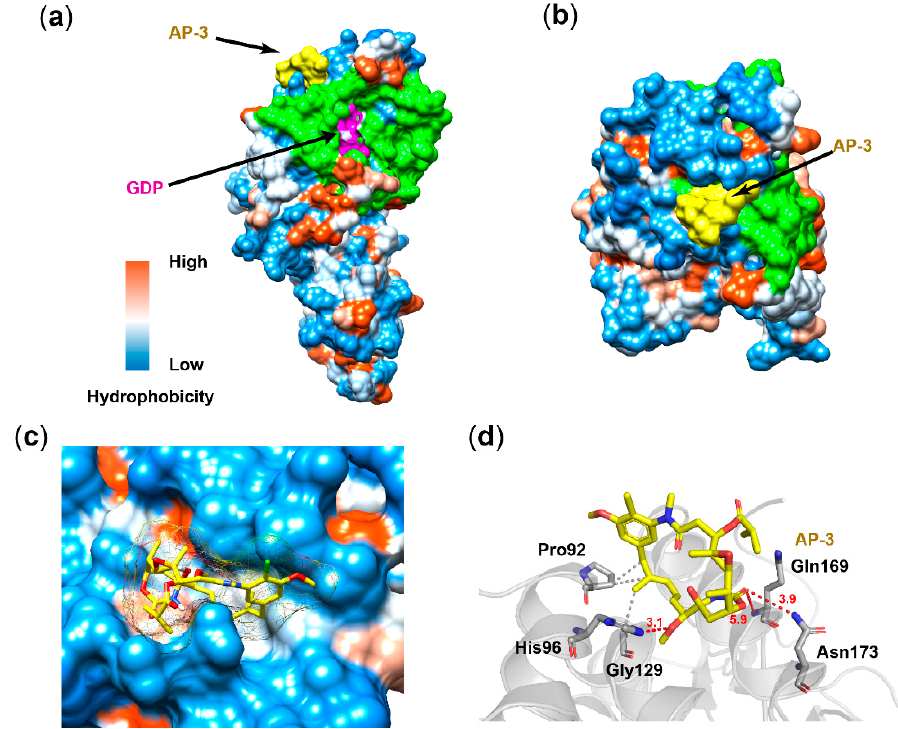
Figure 4. Interaction of FtsZ and AP-3 revealed by docking analysis. ( a ) The binding site of AP-3 on FtsZ is apart from the GDP binding site, from side view. The surface of FtsZ is displayed by hydrophobicity. Orange and blue indicate high and low hydrophobicity, respectively. The junction interphase between two FtsZ monomers is colored in green. ( b ) The binding site of AP-3 on FtsZ, from top view. ( c ) Close-up view of the AP-3 binding groove on FtsZ. The colors on the groove indicate that this part is more hydrophobic than the surrounding area. ( d ) The key amino acid residues interacting with AP-3. The interactions between key amino acids and AP-3 are displayed by dashed lines. Red dashed lines represent hydrogen bonds, and grey dashed lines represent hydrophobic interactions. The bond lengths (Å) are indicated by the numbers beside the dotted lines.